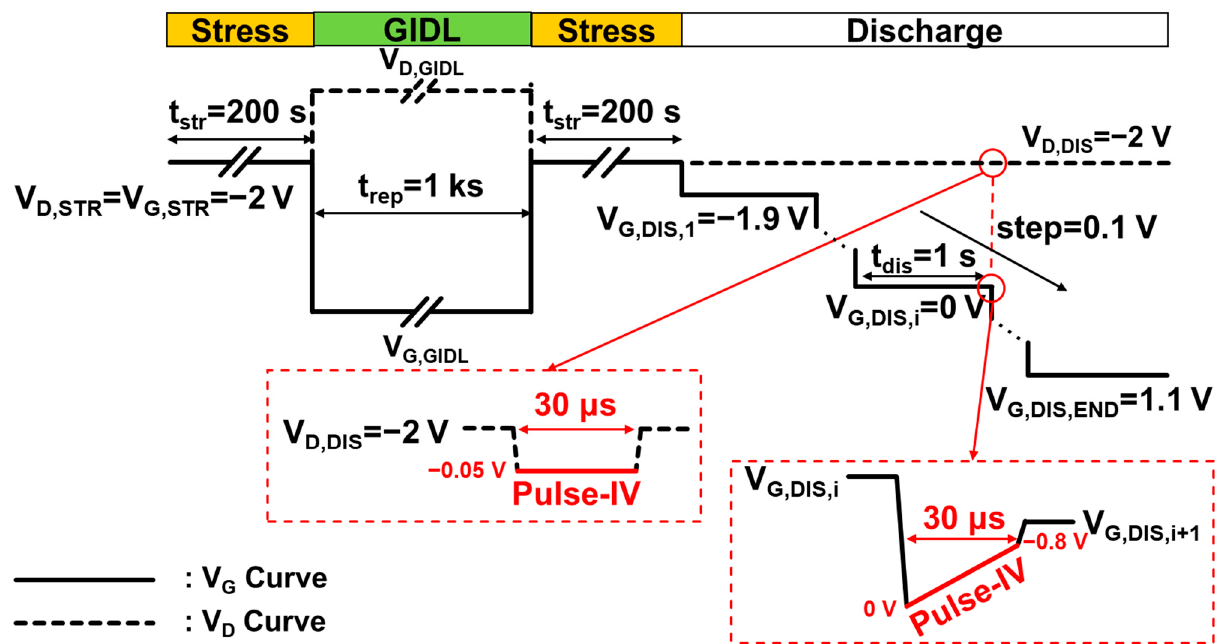
Figure 2. V D and V G test waveforms for the DMP test. Solid curve: V G test waveform. Dashed curve: V D test waveform. Red curve: Pulse-IV measurement.